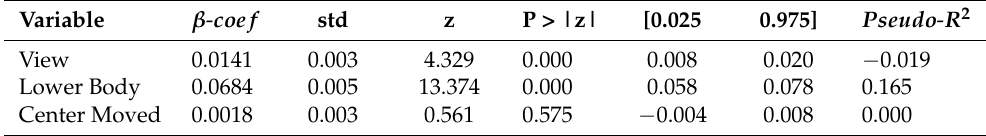
Table 7. The results of the logistic